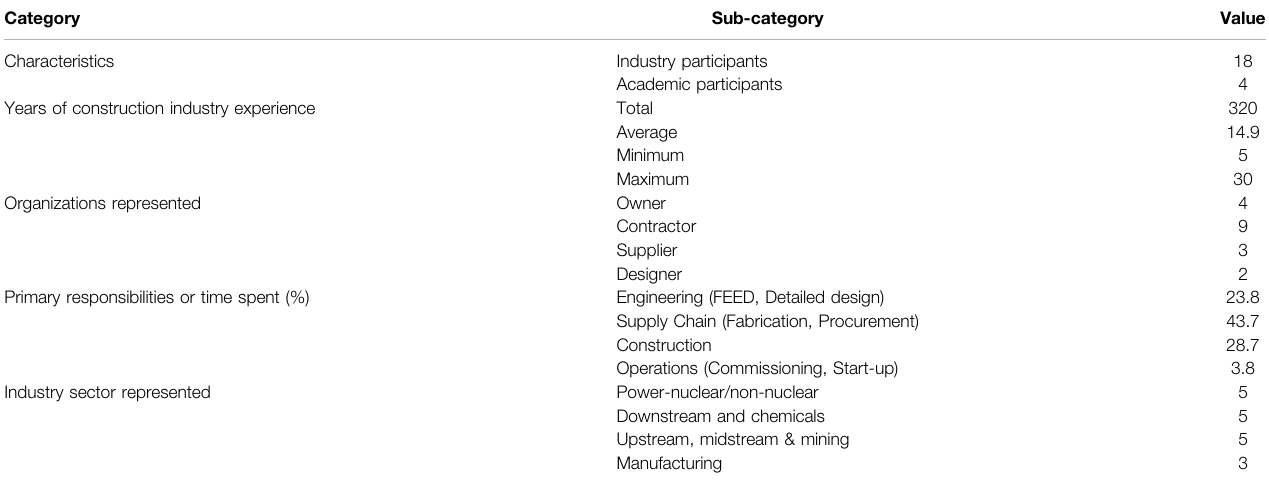
TABLE 2 | Expert panel background